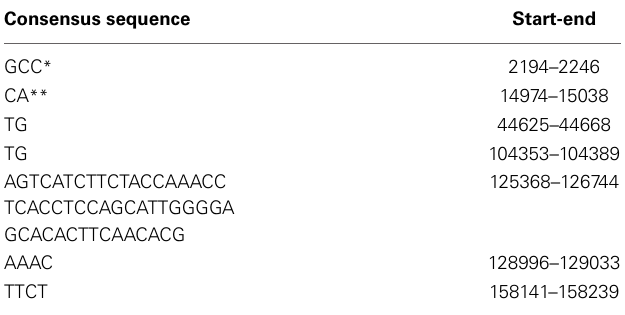
Table 4 | Tandem repeats in Rb1 . Table 5 | CTCF binding motifs within the Genomic Region under